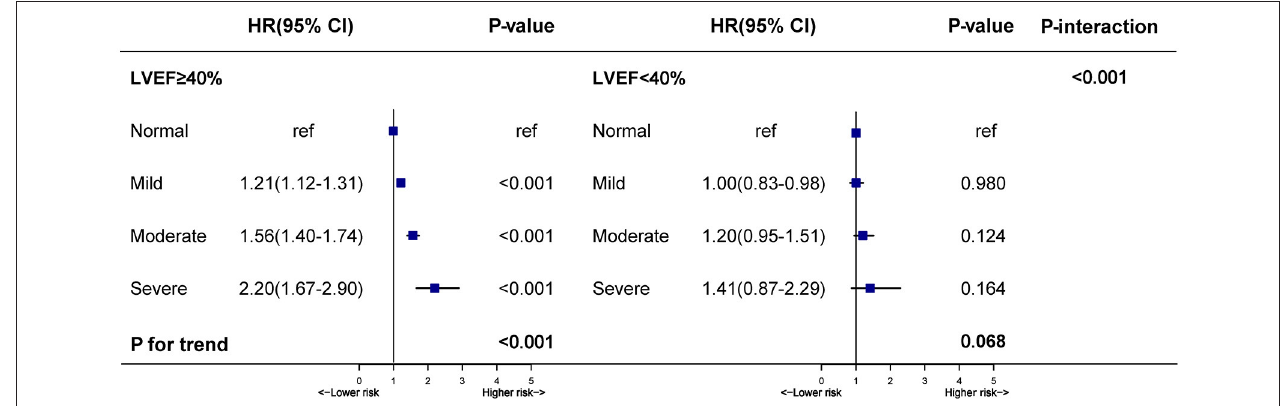
FIGURE 3 | Hazard ratios for all-cause mortality stratified by the nutritional state in patients with LVEF ≥ 40% and LVEF < 40%. Model adjusted for age, gender, percutaneous coronary intervention; hypertension; diabetes mellitus; anemia; stroke; coronary artery disease; chronic kidney diseases; atrial fibrillation; low-density